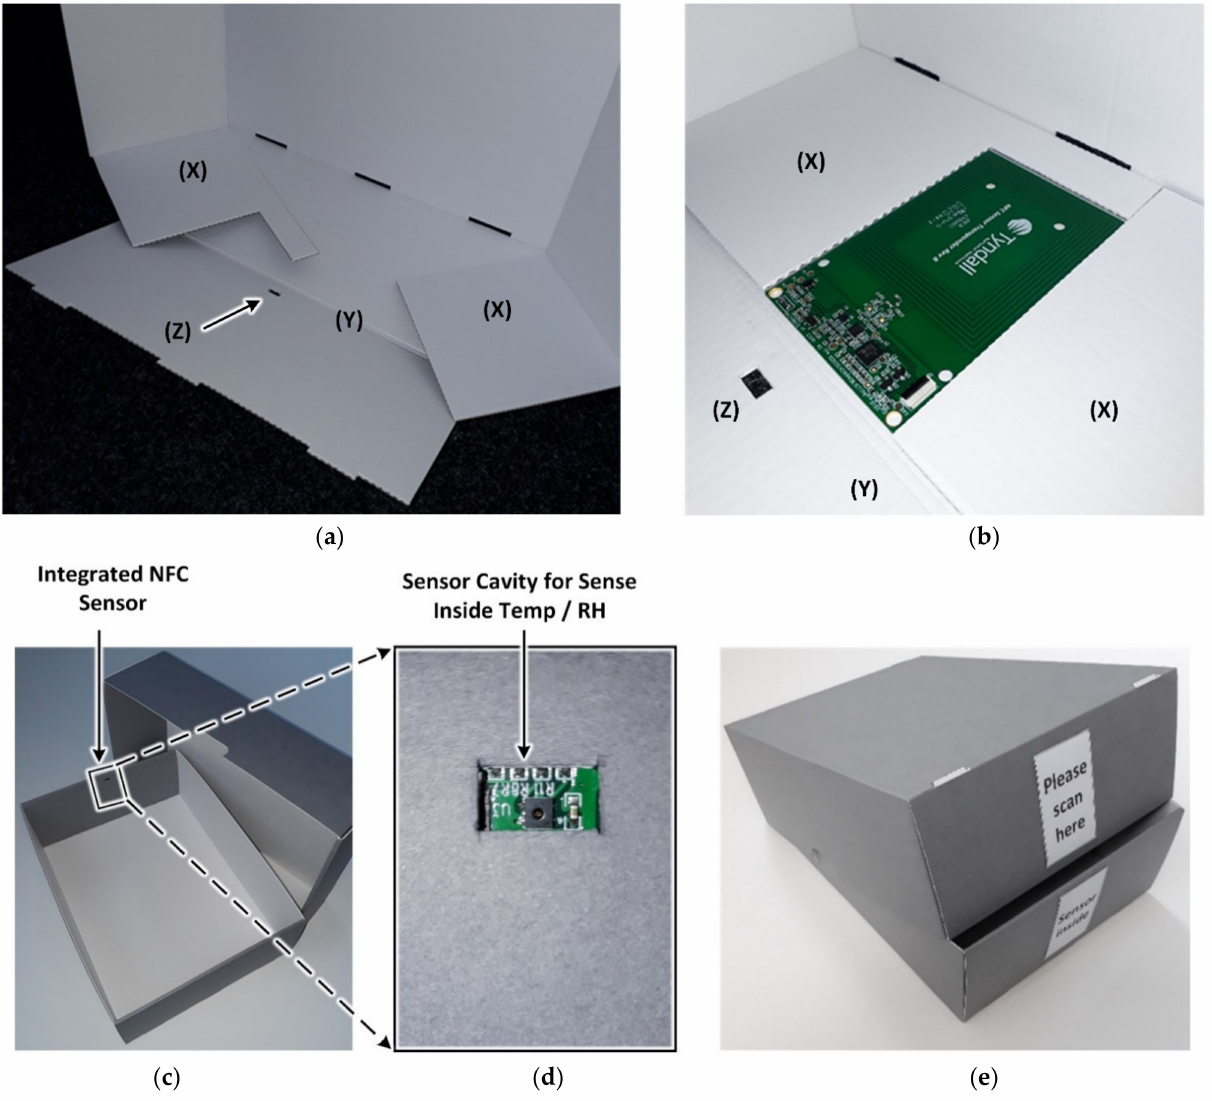
Figure 6. NFC sensor integration ( a ) Short front side of the flipped open telescope box bottom without the NFC sensor, ( b ) with integrated NFC sensor ( c ) integrated view of NFC sensor ( d ) view of sensor cavity for sensing inside temp/RH, and ( e ) labelled base and lid displaying construction assembly for